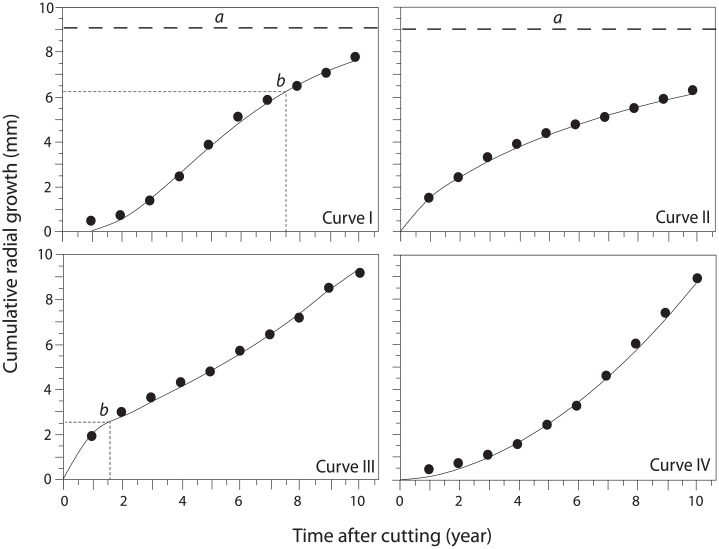
Examples of the four growth patterns using the Schnute function.The discontinuous horizontal lines indicate the asymptotes (a). The thin discontinuous horizontal and vertical lines show the inflexion points (b). The black dots show the cumulative radial growth values for each study year and the continuous lines represent the model fitting.